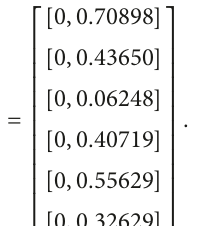
Interval steepest descent method obtained estimations ̃𝑦 1 and ̃𝑦 2 at iterations 6 and 12 when 𝜃 = 10 respectively. The accuracy of ̃𝑦 1 and ̃𝑦 1